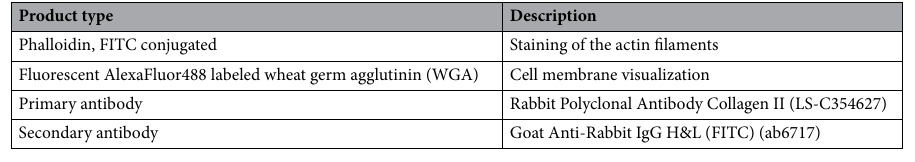
Table 1. Employed antibodies for